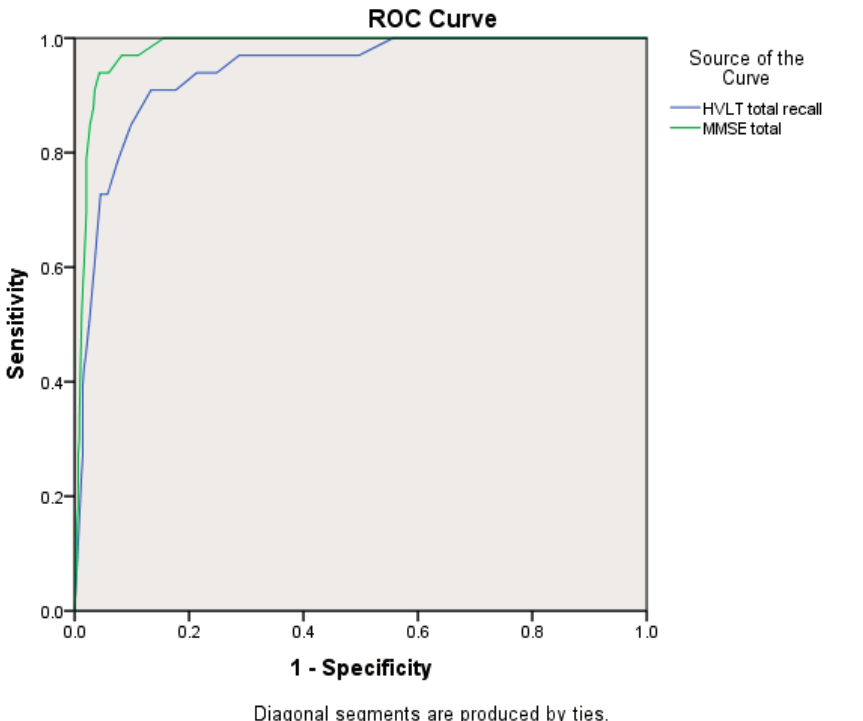
Figure 1. ROC analysis for the HVLT and the MMSE in discriminating dementia patients from non-dementia